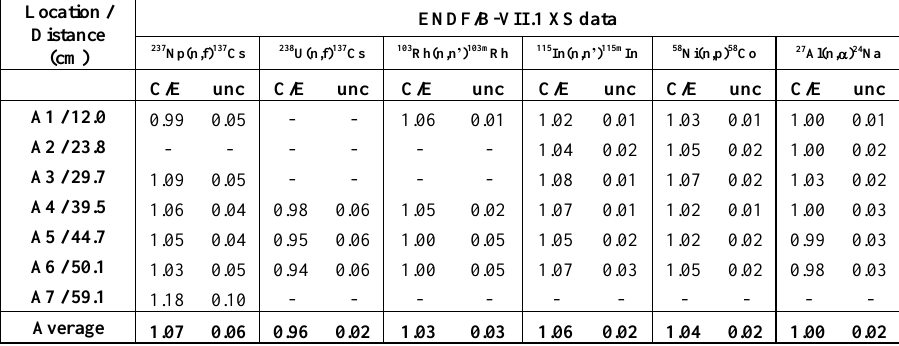
Table 3 : C/E specific activity ratios for the PCA benchmark problem. Uncertainties of averages